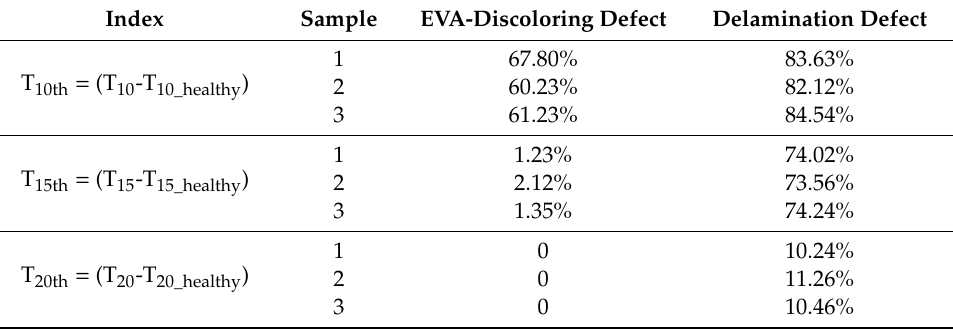
Table 8. Certainty grade values of the fuzzy rule for a different case.